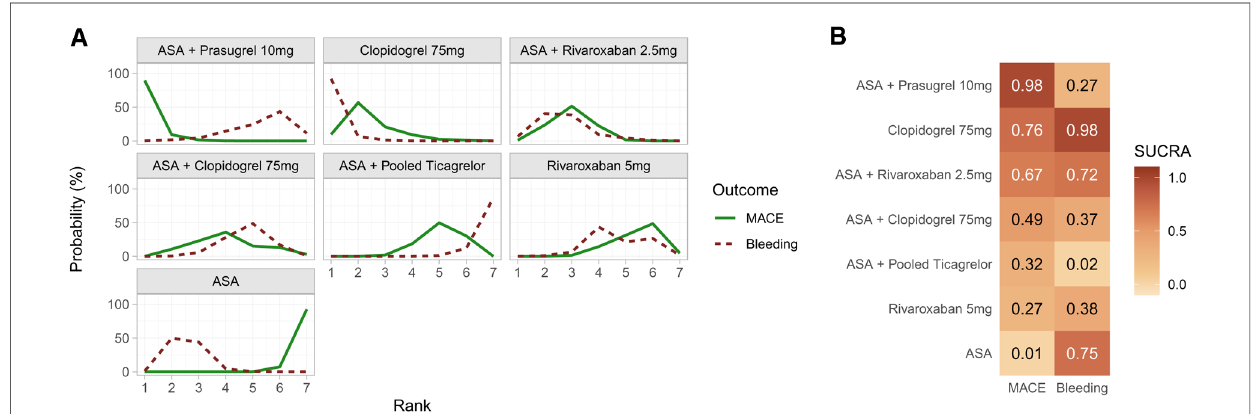
FIGURE 3 ( A ) ranking probabilities for MACE (solid line) and bleeding (dotted line) outcomes for each treatment. ( B ) heatmap with corresponding SUCRA values. While each row corresponds to a treatment, each column depicts one